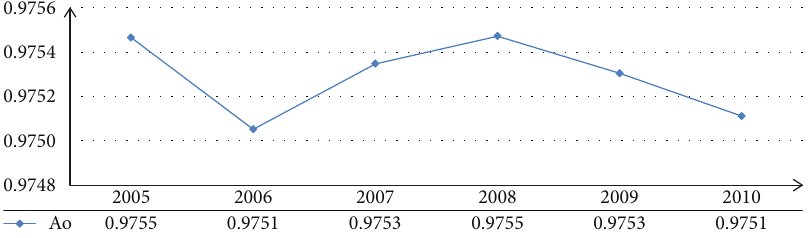
Figure 8: Characteristic form of operational availability function for period